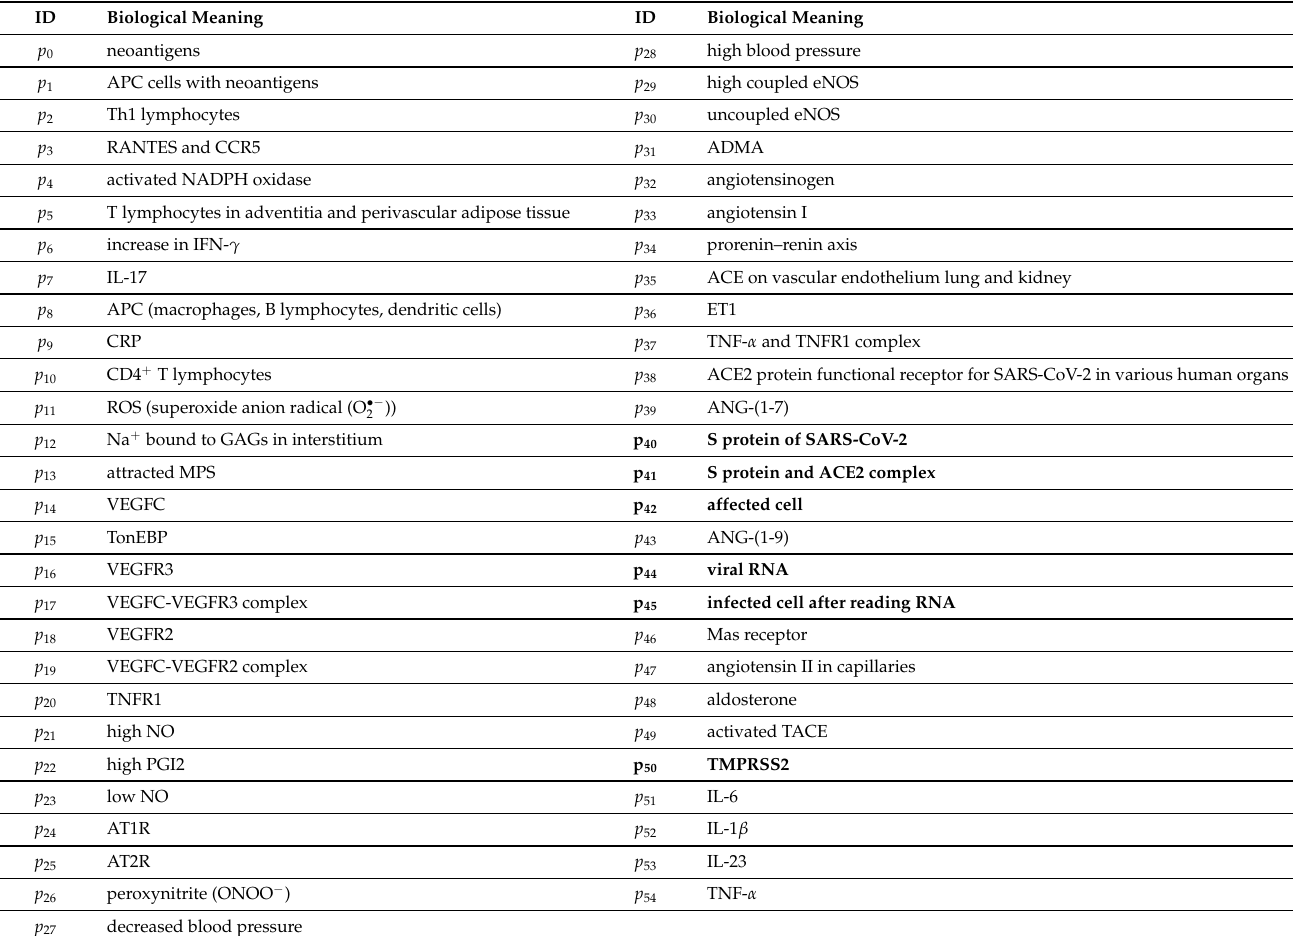
Table 2. List of places of the model with SARS-CoV-2.